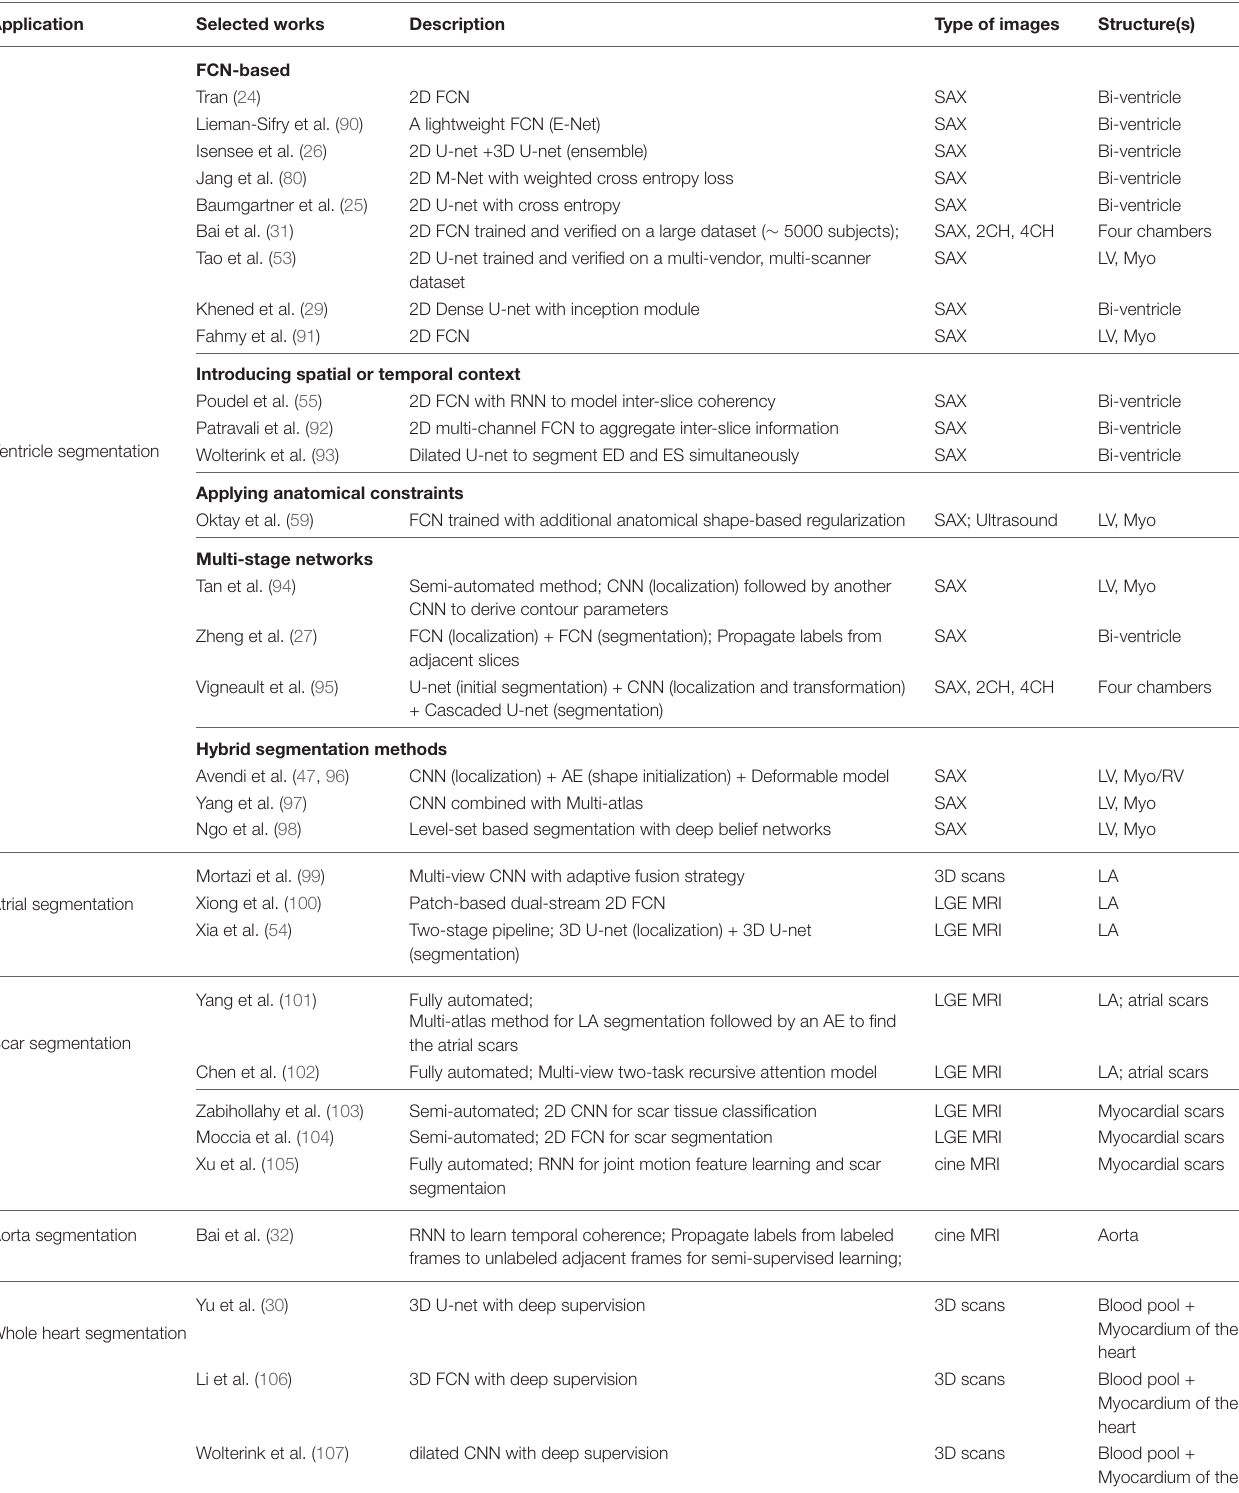
TABLE 1 | A summary of representative deep learning methods on cardiac MRI segmentation.